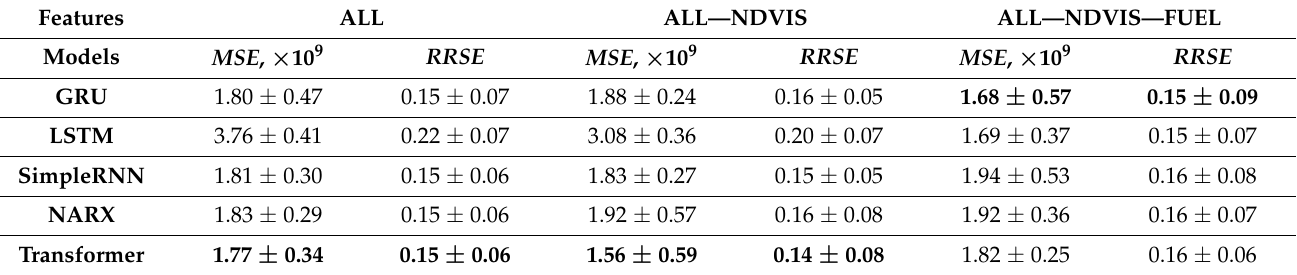
Table 4. Production prediction scores for the baseline models.